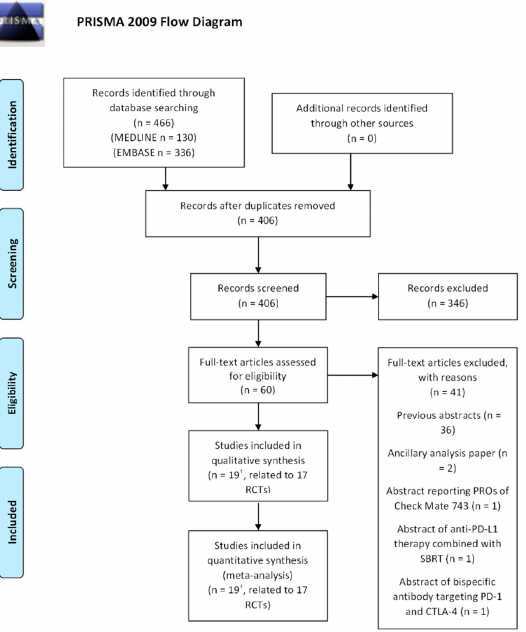
Figure 1. PRISMA flowchart of selected trials. † The studies by Hayashi et al., 2020 [26] and Calabrò et al., 2021 are updates of the MERIT (Okada et al., 2019) and NIBIT-MESO1 (Calabrò et al., 2018) RCTs, respectively.